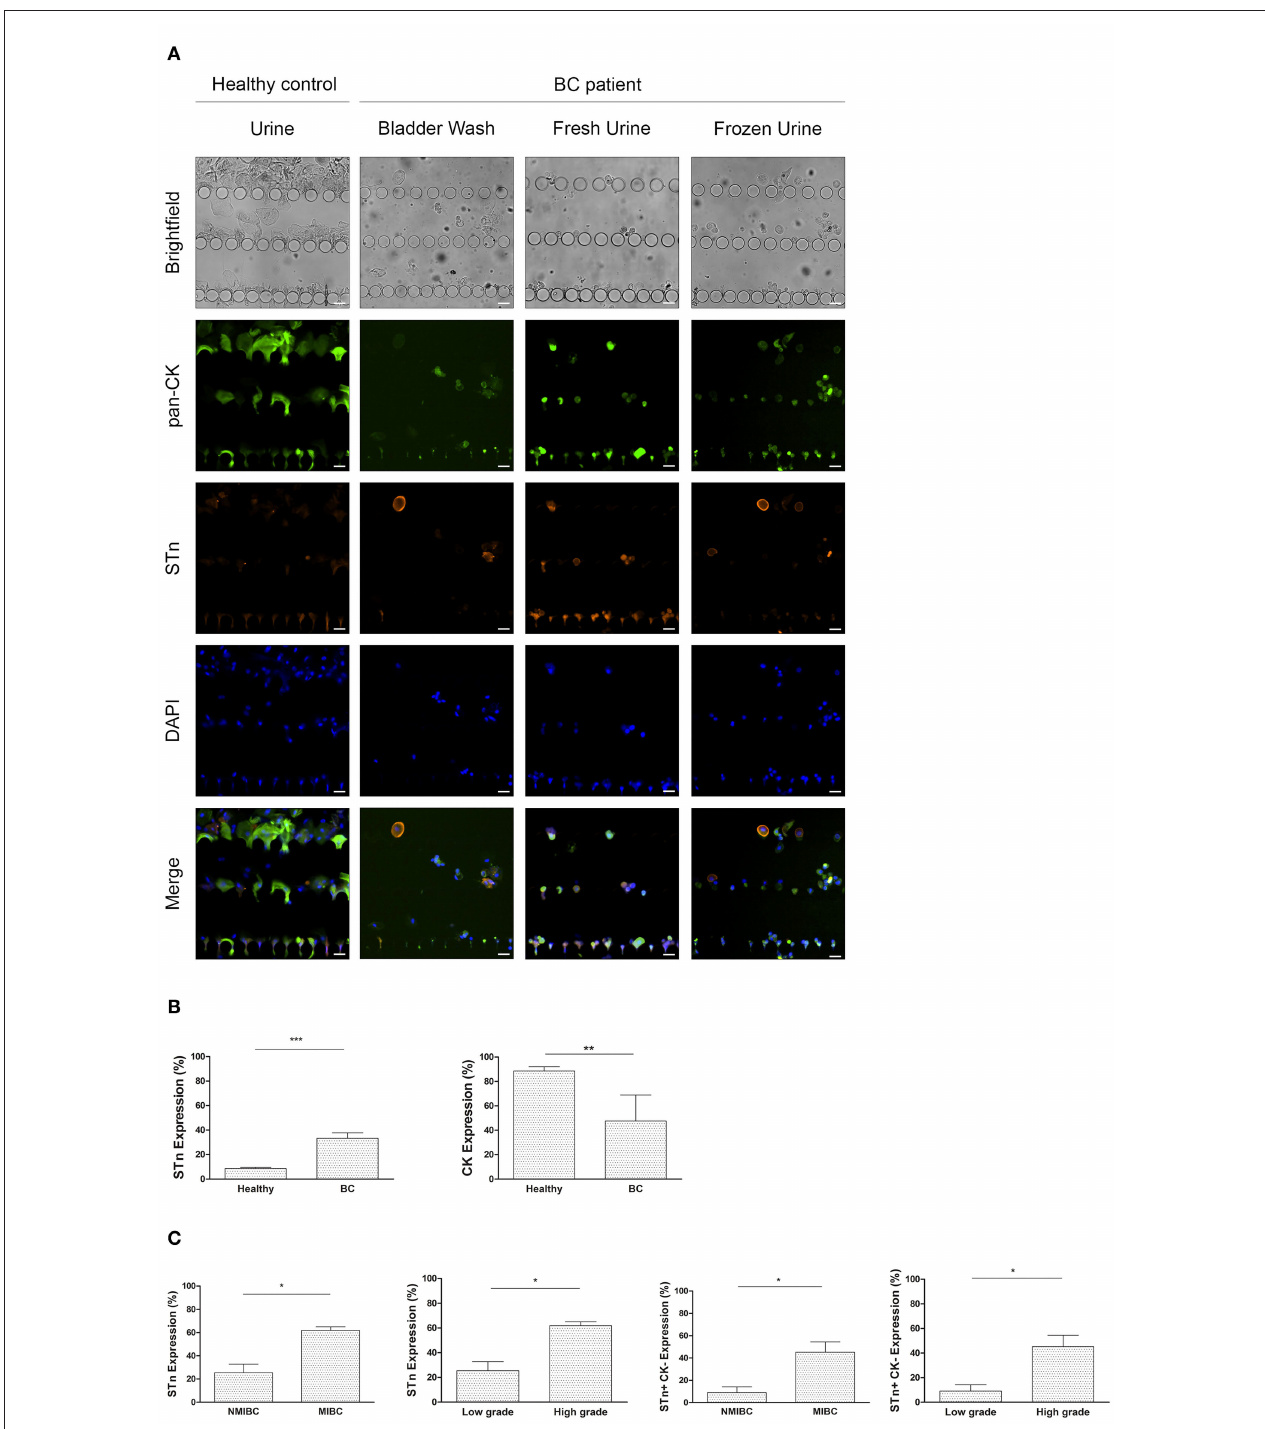
FIGURE 6 | STn expression in bladder urothelial ETC isolated by the UriChip. (A) Immunofluorescence staining pattern of urothelial exfoliated cells captured in the UriChip from healthy controls and BC patient samples, namely bladder washes and voided urine, subjected or not to cryopreservation. Cells were probed for STn antigen (orange), pan-CK (green), and DAPI (blue). ETCs were identified according to the following criteria: DAPI-positive, STn-positive, and pan-CK-positive or negative. Scale bar, 20 µ m. (B) Percentage of STn and pan-CK-positive cells in BC patients vs. healthy controls. As expected, expression of STn is significantly higher in BC (33.28%) compared with healthy controls (8.57%). p = 0.0006. In contrast, CK expression decreases significantly in BC (from 8.55% in healthy controls to 47.62% in BC). p = 0.0015. (C) Correlation of STn-positive and STn-positive/CK-negative cell count with tumor invasiveness and grade. Capture of STn-positive cells and STn-positive/CK-negative cells in the UriChip are significantly higher in muscle invasive BC and high grade bladder tumors ( p = 0.0127). Statistical significance * p < 0.05, ** p < 0.01, *** p < 0.001.